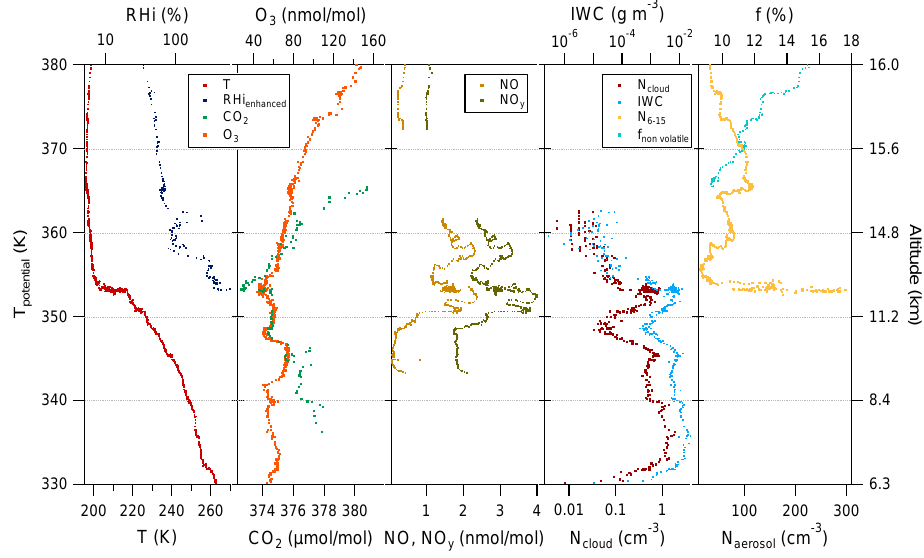
Fig. 12. Vertical profiles recorded by the M-55 Geophysica during its ascent from Ouagadougou, Burkina Faso, on 16 August 2006.